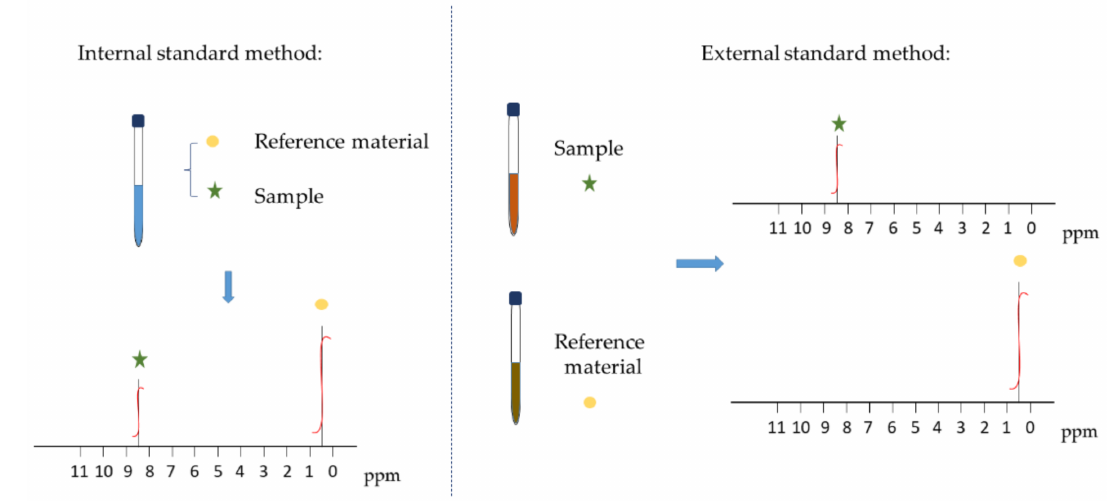
Figure 2. Internal standard and external standard